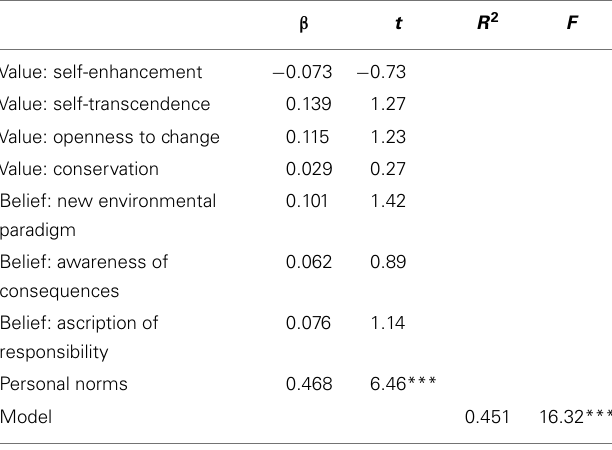
Table 5 | Hierarchical regression results forTPB (model 1) and the combined variables fromTPB and the appraisal–emotion approach (model 2, N = 168)